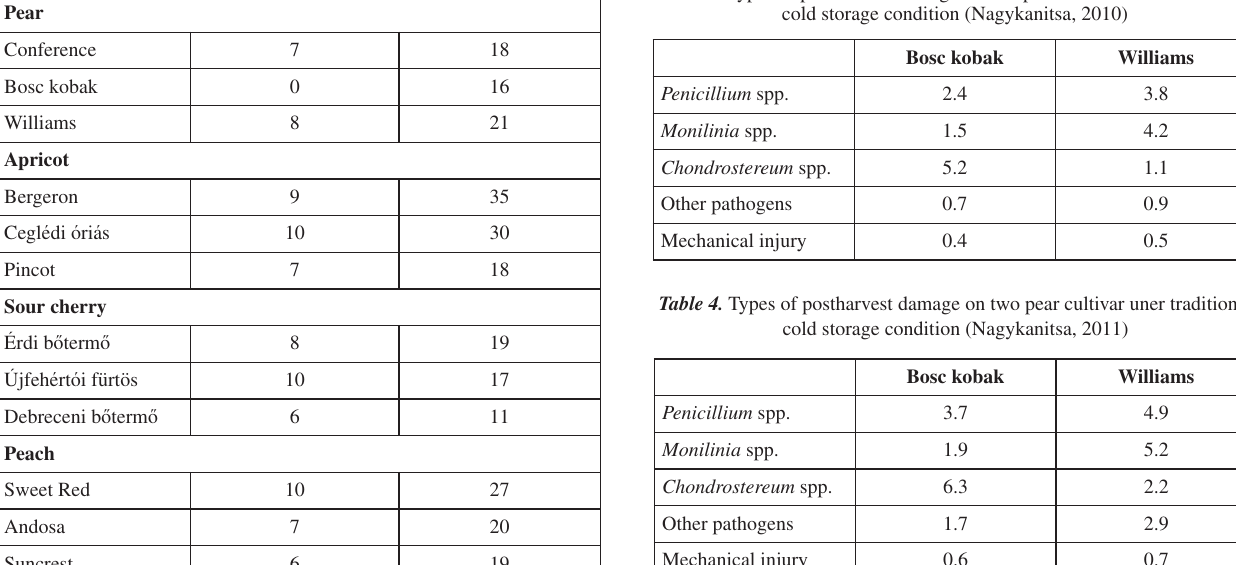
Table 1. Incidence of postharvest deacy of fruit of four fruit species under two storage conditions (Nagykanizsa, 2010) Controlled atmosphere